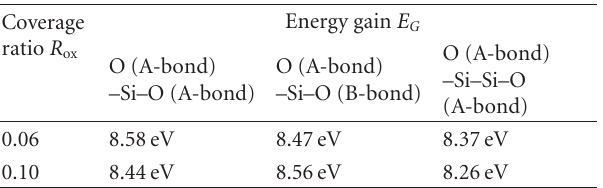
Table 1: Energy gains E G with absorption of two O